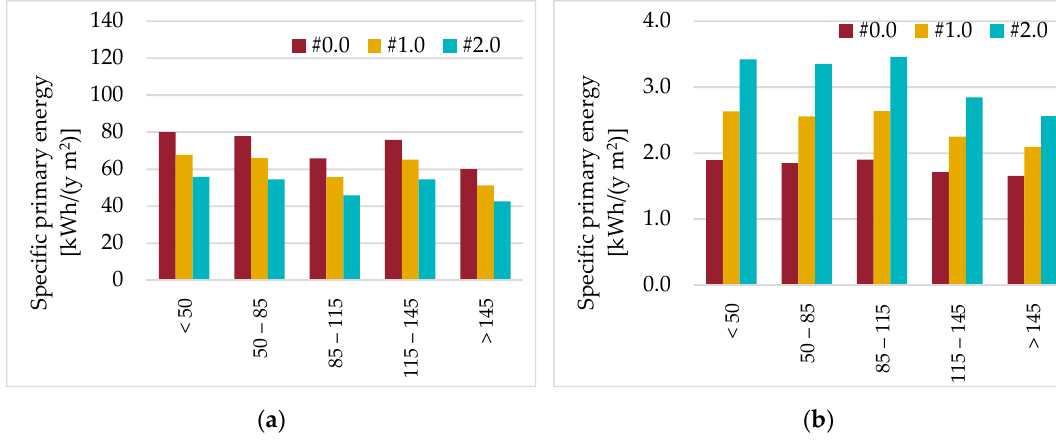
Energies 2020 , 13 , x FOR PEER REVIEW Figure 11. Florence: Specific primary energy consumption. ( a ) Heating; ( b ) cooling.